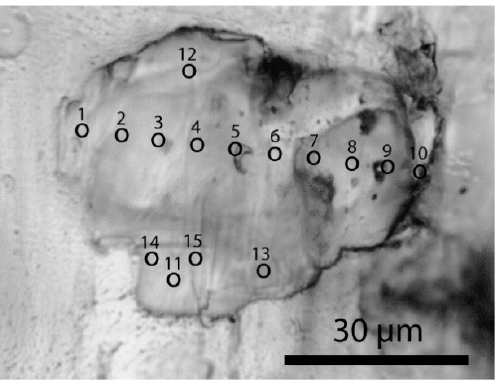
Figure 2. Aggregate of coesite-I in prismatine from the Waldheim/Saxon Granulite Massif. Points 1–15 mark the points of the Raman measurements. Note that between coesite and prismatine there is a partial thin layer of clinochlore. a partial thin layer of